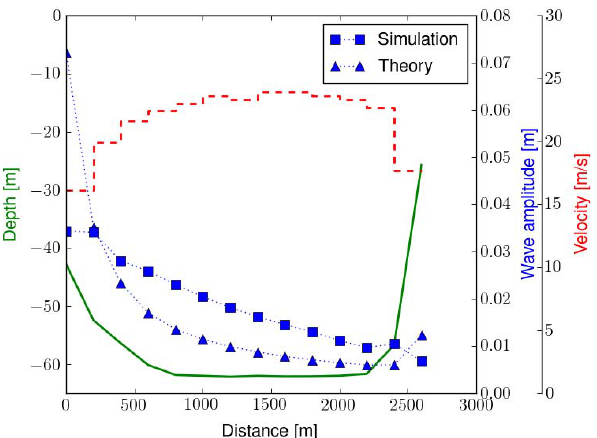
Fig. 6c. Wave propagation in south direction.